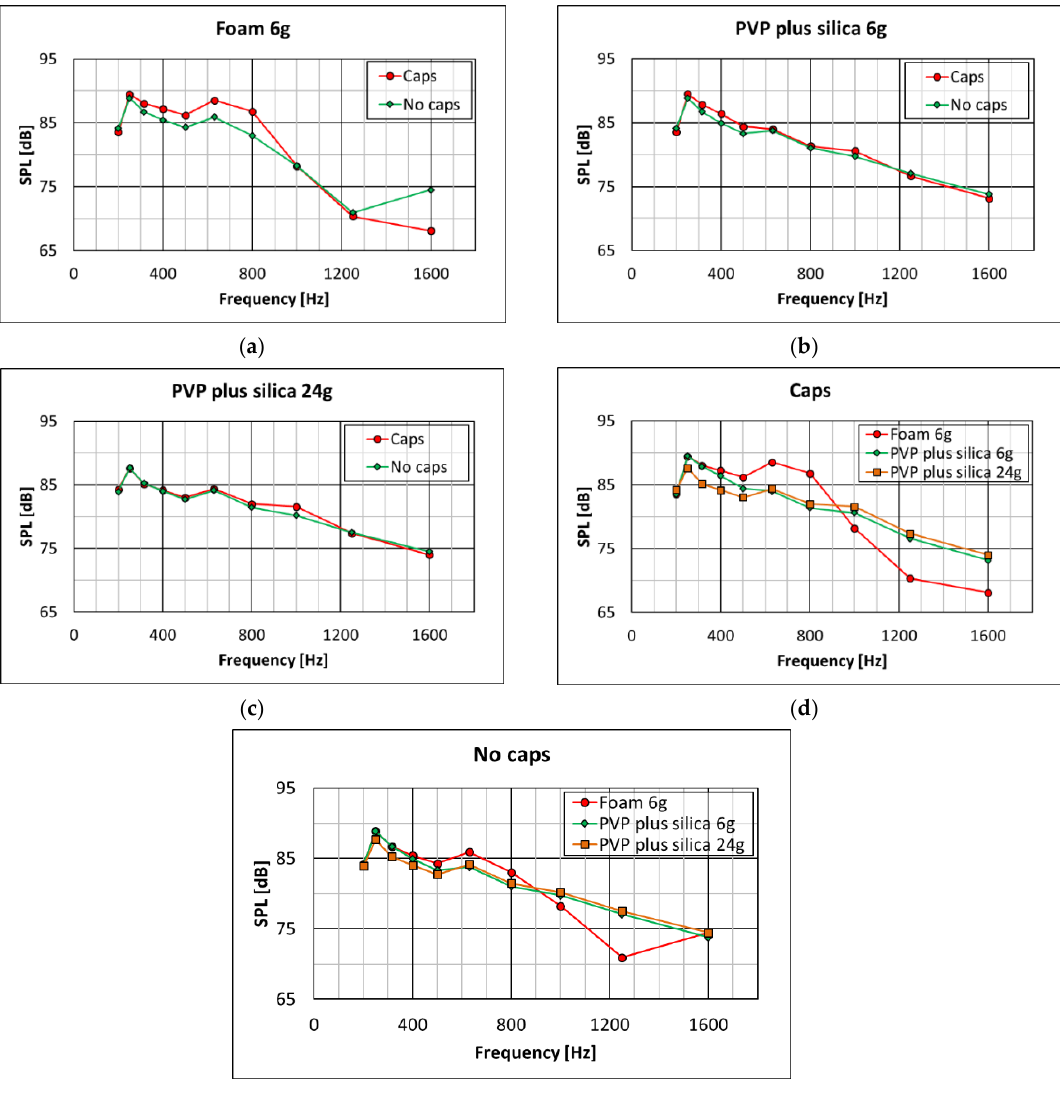
Figure 7. SPL vs. frequency spectra for the various headrest configurations with reference to the three considered materials ( a – c ) and to the two considered headrest’s shapes ( d – e ).